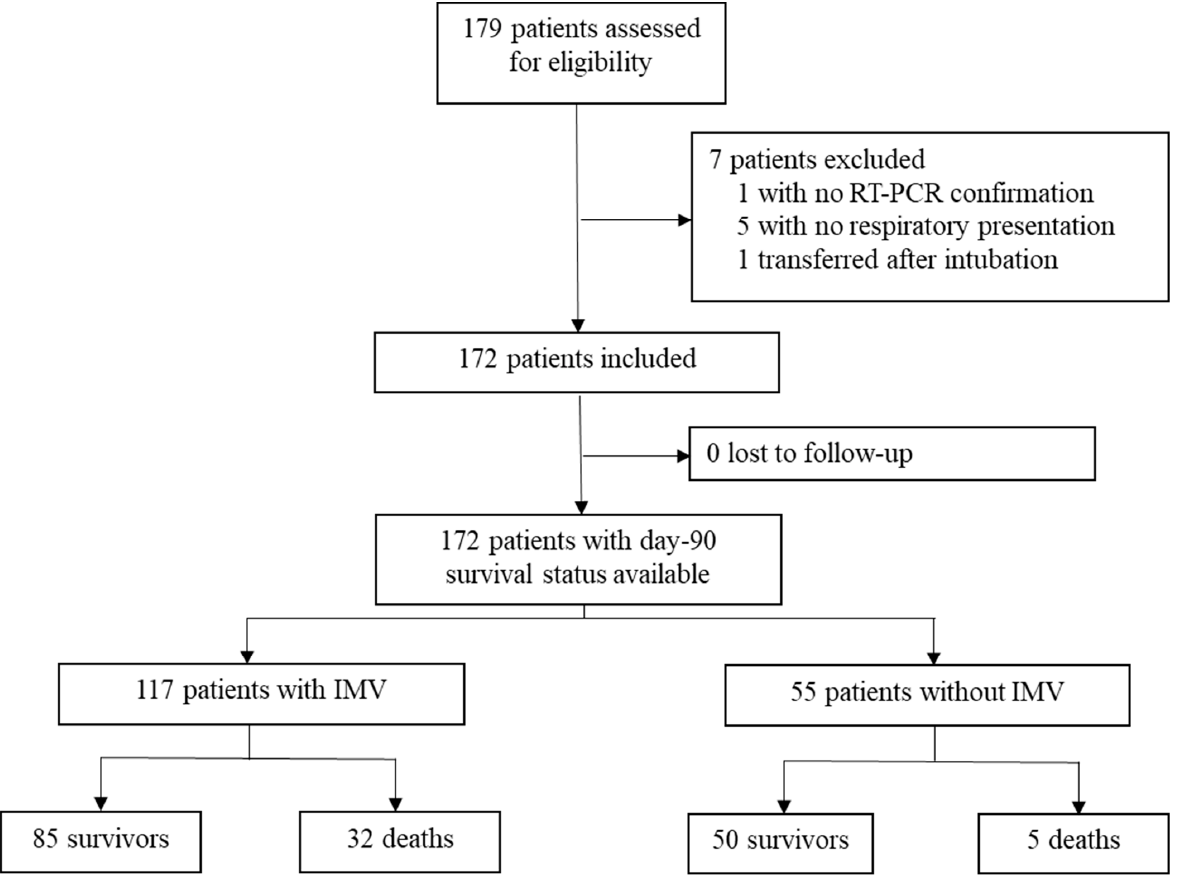
Figure 1. Flow Chart of the population study.